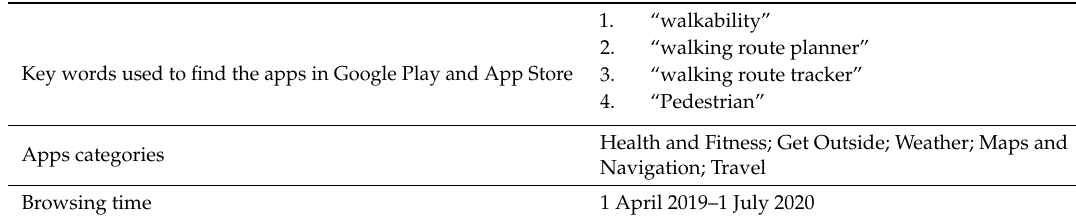
Table 1. Criteria used to search Google Play Store and App Store.